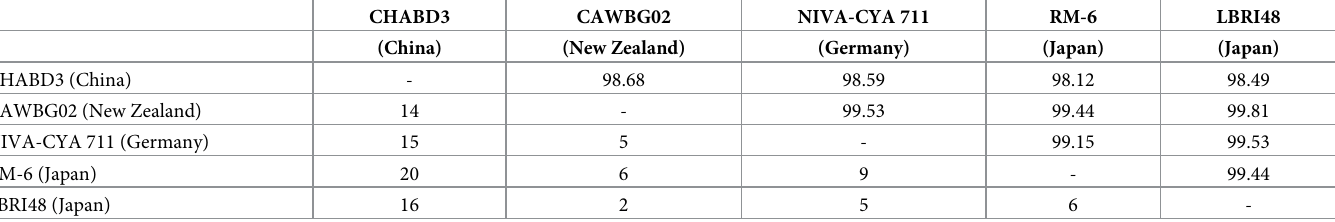
Table 1. Similarities of the 16S rRNA gene based on 1,063 base pairs for Cuspidothrix issatschenkoi strain NIVA-CYA 711 (FN689797; Germany), CAWBG02 (EF638715; New Zealand), CHABD3 (FJ424558; China), LBRI48 (KM245026; Japan) and RM-6 (KM245027; Japan). The values in the upper right triangle are the per- cent identities between a pair of sequences. The values in the lower left triangle are the numbers of dissimilar nucleotides.